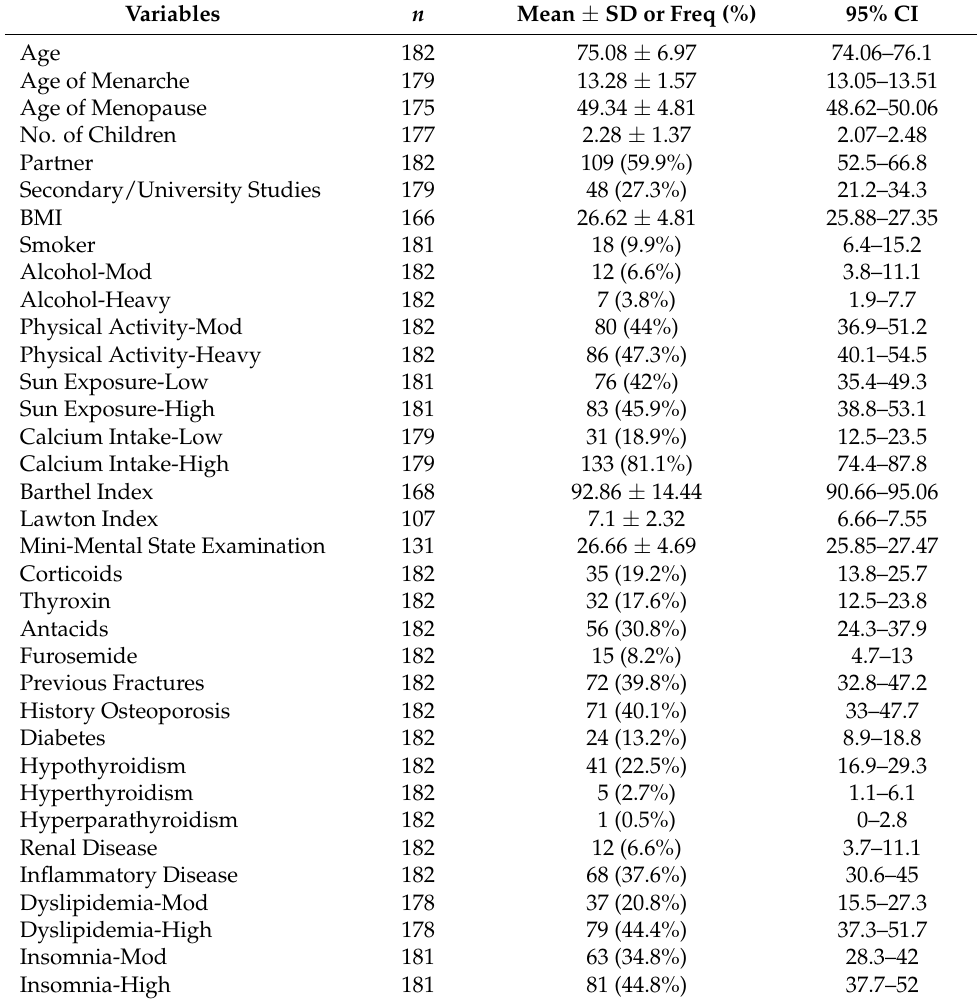
Table 1. Distribution of risk factors for osteoporosis, lifestyle habits, and